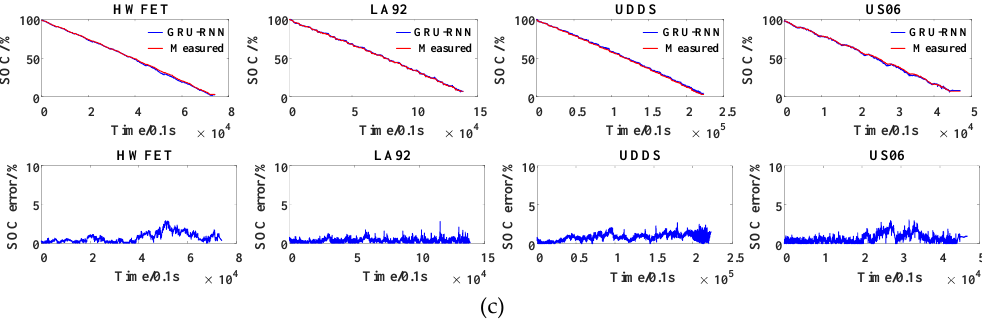
Figure 8. SOC estimation curves trained on multi-temperature data: ( a ) 0 °C, ( b ) 10 °C, ( c ) 25 °C Table 2. SOC estimation result of the GRU-RNN trained on multi-temperature data.